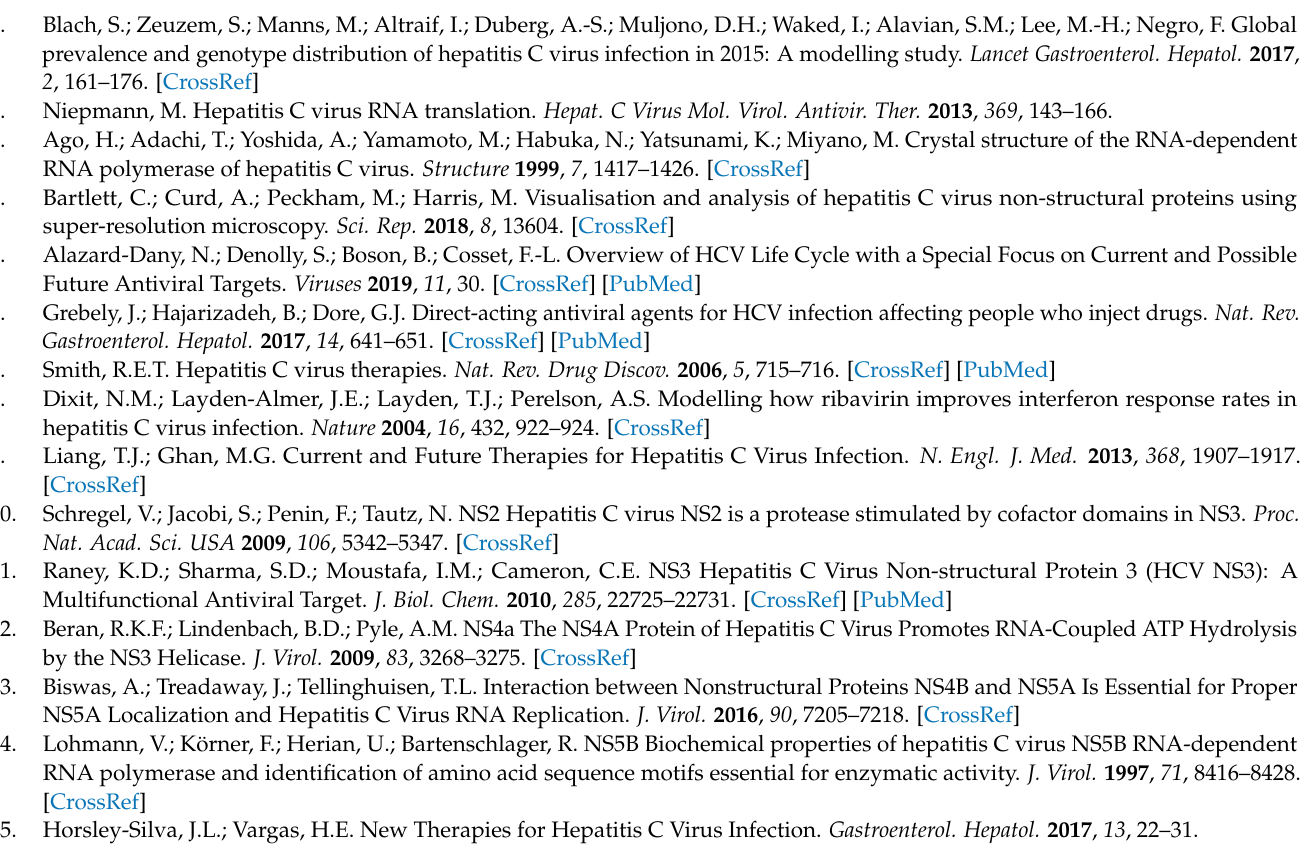
PAGE- coomassie staining analysis of the two-step chromatography purification cascade, Figure S4: SDS-PAGE analysis of the two-step chromatography purification process for TyrAB and Tyr50 kDa, Figure S5: 3D structure of the active site area of phosphoprotein NS5A, Figure S6: SDS-PAGE with coomassie staining of the enzymes solution directly produced from fresh mushrooms, Figure S7: Inhibition of the Hepatitis C virus (HCV) replicon in cell